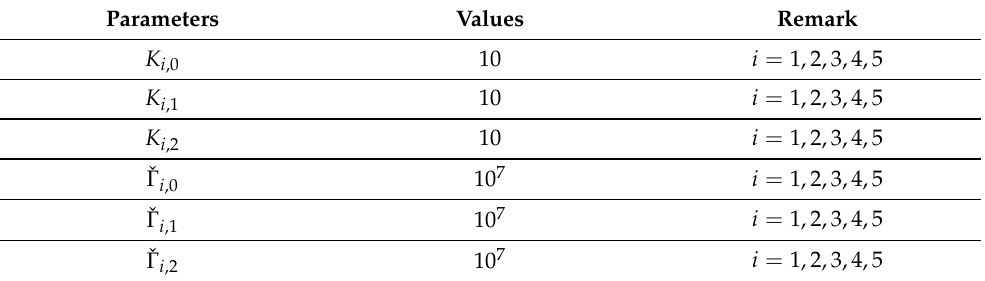
Table 4. Controller parameters of